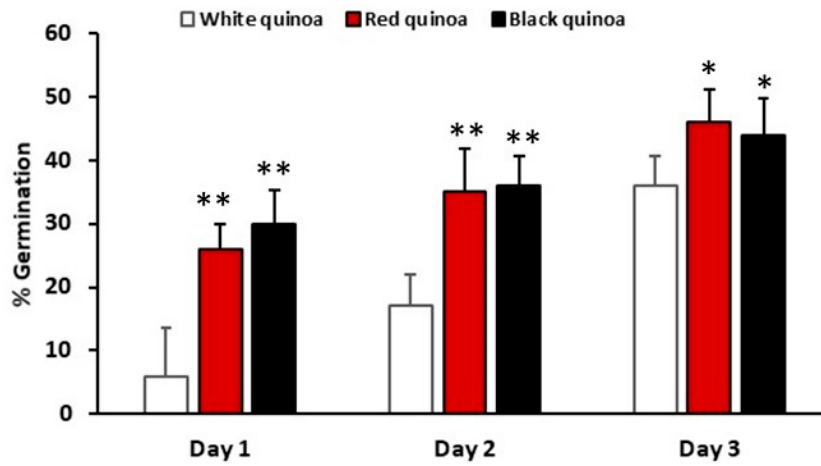
Figure 3. Percentage of germination of white, red and black quinoa ( Chenopodium quinoa Willd) seeds for 24, 48 and 72 h at 28°C. Means ± (SD), black and red quinoa were compared to white quinoa. Tuckey’s test at **P < 0.05; *P < 0.01.